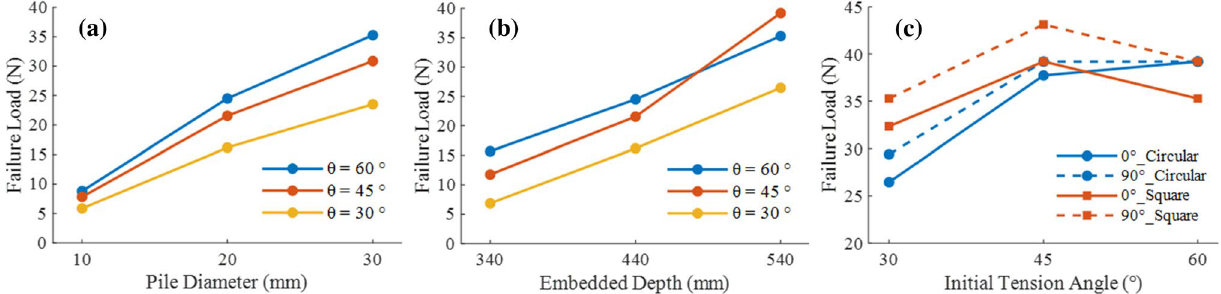
Figure 8. Failure loads of anchor pile models with variables in pile diameter ( a ), embedded depth ( b ) and pile configuration ( c